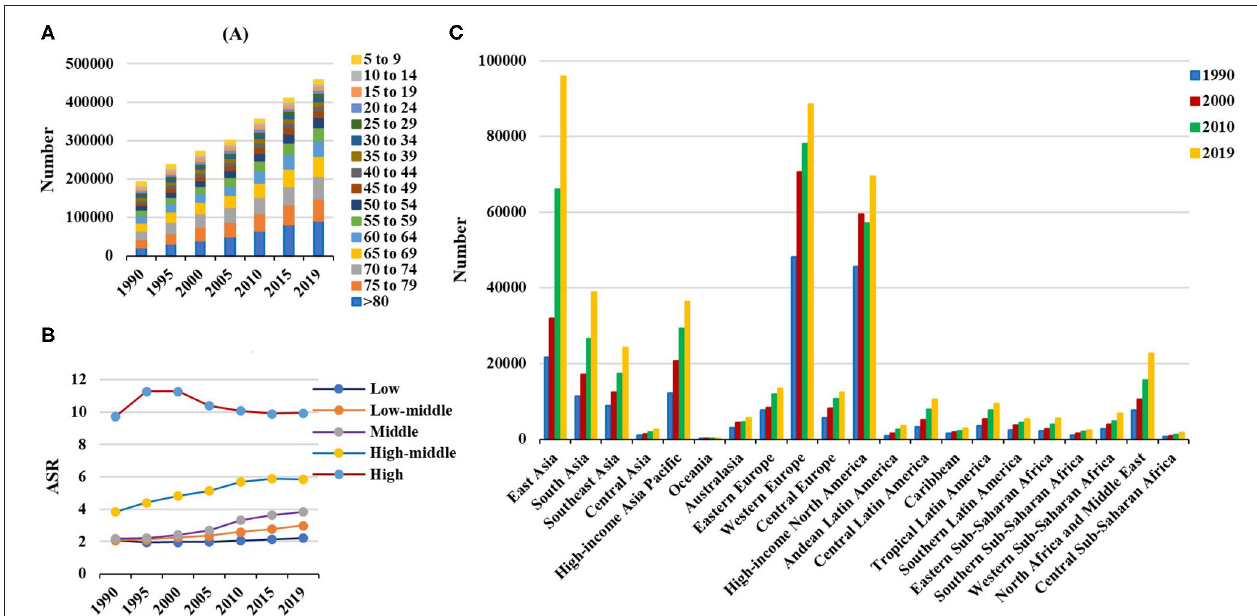
FIGURE 2 | Incident number of non-Hodgkin lymphoma in age groups, SDI areas, and geographic regions from 1990 to 2019. (A) Incident number in age groups; (B) ASIR in SDI areas; (C) incident number in geographical regions. SDI, sociodemographic index; ASIR, age-standardized incidence rate.